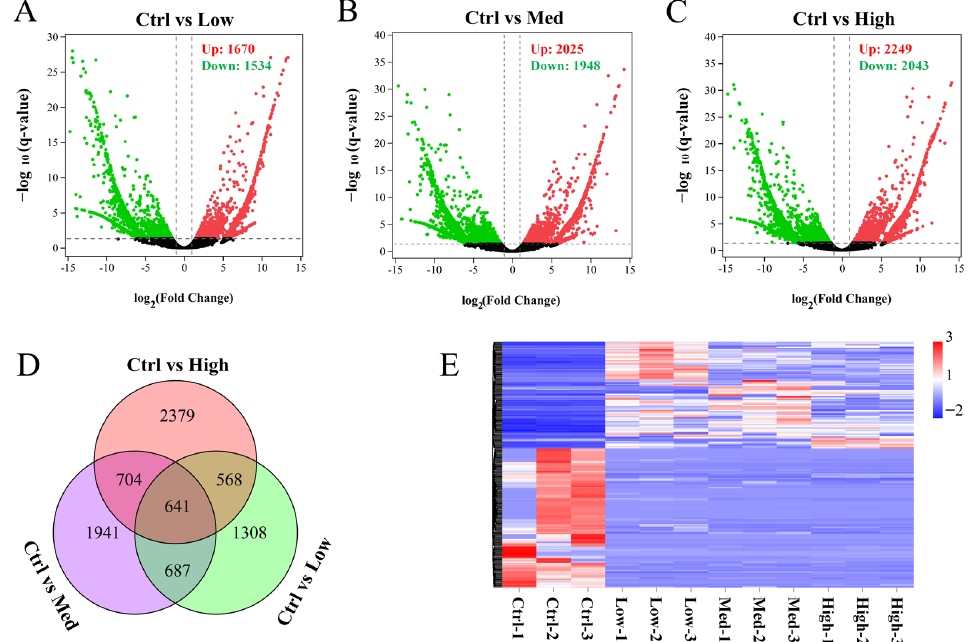
Figure 3. DEGs were identified after treatment with different concentrations of Hg. Volcano plots for DEGs in the 3 comparisons: ( A ) Ctrl vs. Low; ( B ) Ctrl vs. Med; ( C ) Ctrl vs. High. The red dots indicate genes that are up-regulated, while the green dots indicate genes that are down-regulated. ( D ) Venn diagram of DEGs in the 3 comparisons. ( E ) Heatmap based on fragments per kilobase of transcript per million mapped reads (FPKM) values showing the variations in expressions of overlapping DEGs. Genes whose expressions were greater than the mean are colored red while those below the mean are colored blue. Ctrl: 0 μ g/L Hg 2+ ; Low: 8.75 μ g/L Hg 2+ ; Med: 21.875 μ g/L Hg 2+ ; High: 43.75 μ g/L Hg 2+ .